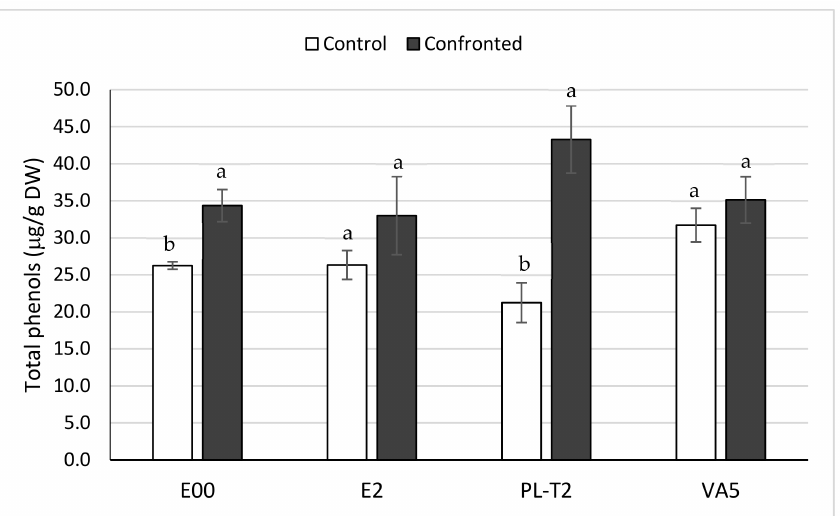
Figure 7. Total phenols content of in vitro grown Q. ilex shoots from control (E00, E2) and tolerant (PL-T2, VA5) genotypes, after 17 days in uninfected (white bars) and infected (dark bars) plates of dual cultures challenged with P. cinnamomi . Data are mean ± SD of two replicated samples analyzed twice. For each genotype, values with the same letter did not differ according to the Tukey-b